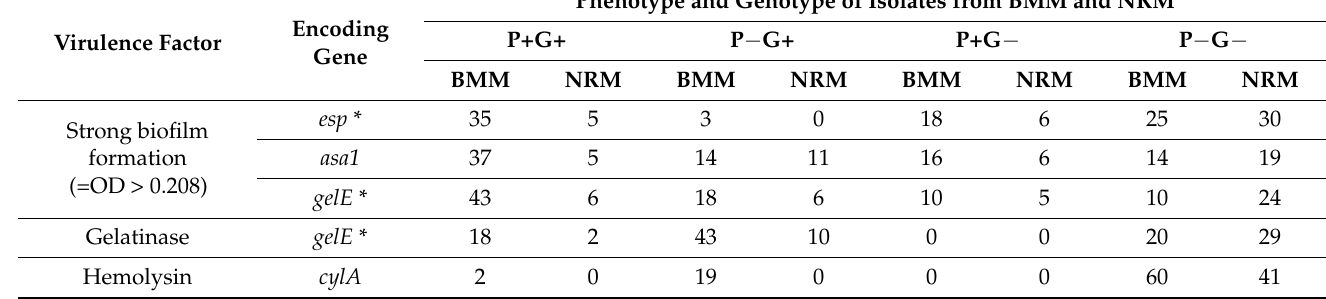
Table 2. Correlation between virulence phenotype and genotype of Enterococcus faecalis and Enterococ- cus faecium isolated from bovine mastitis milk (BMM) and bovine normal raw milk (NRM). Phenotype and Genotype of Isolates from BMM and